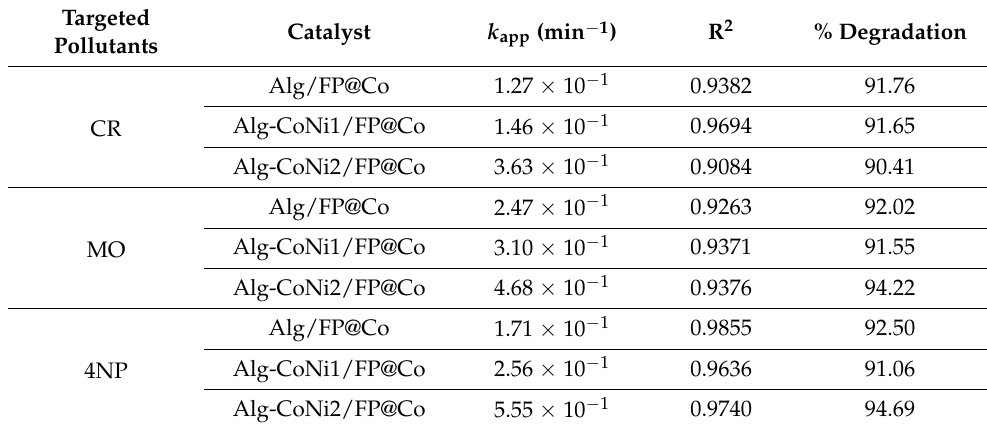
Table 2. Kinetics parameters based on pseudo-1st order and % degradation of CR, MO dyes, and 4NP.